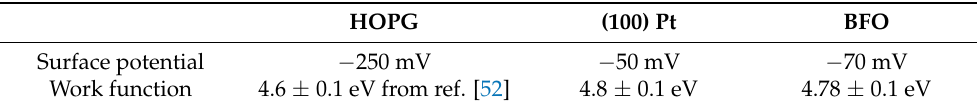
Table 1. The results of the surface potential measurements for three different samples and its recalculation to work